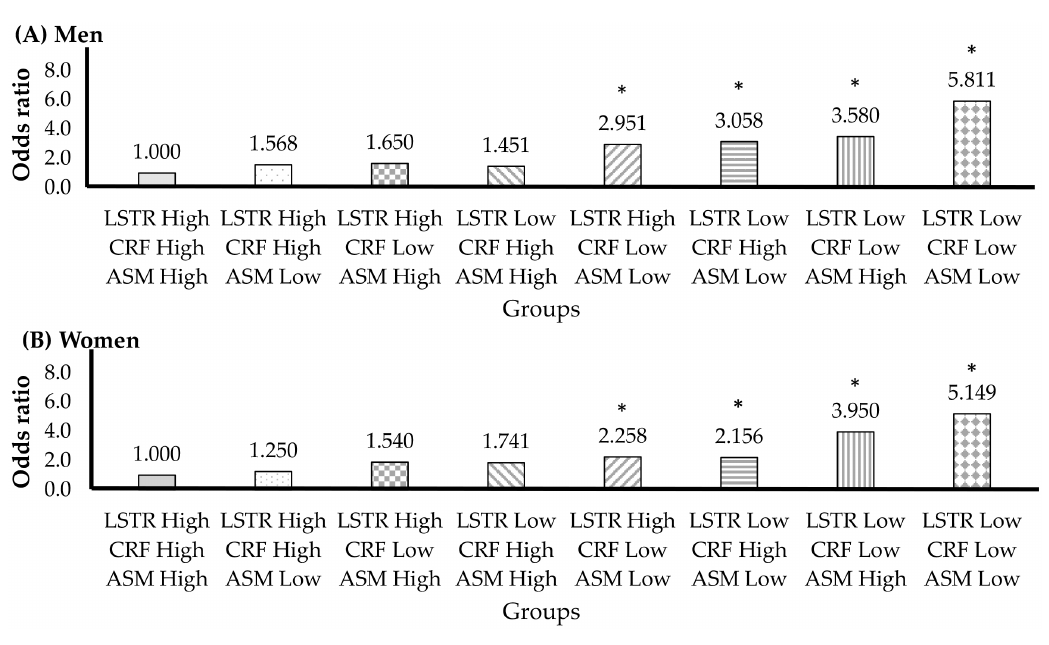
Fig. 1. The odds ratio based on combinations of leg strength, cardiorespiratory fitness, and appendicular skeletal muscle mass. (A) Men, (B) Women, * p -value < 0.05; LSTR, leg strength; CRF, cardiorespiratory fitness; ASM, appendicular skeletal muscle mass. Adjusted variables included age, alcohol consumption, smoking, and physical